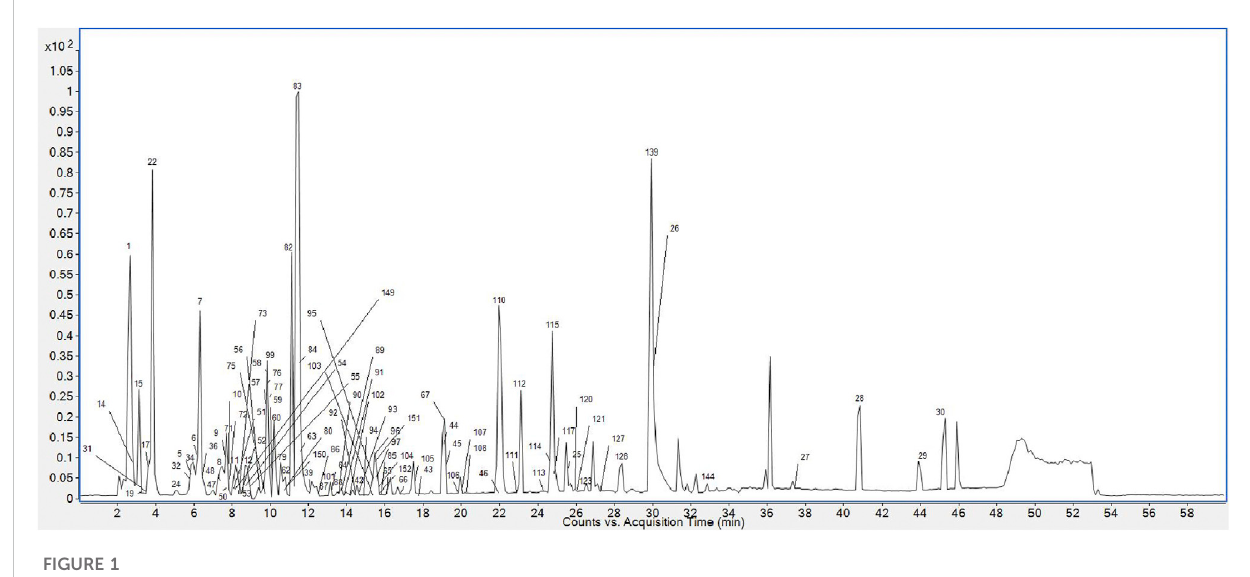
FIGURE 1 BPC of PMR 70% ethanol extract.